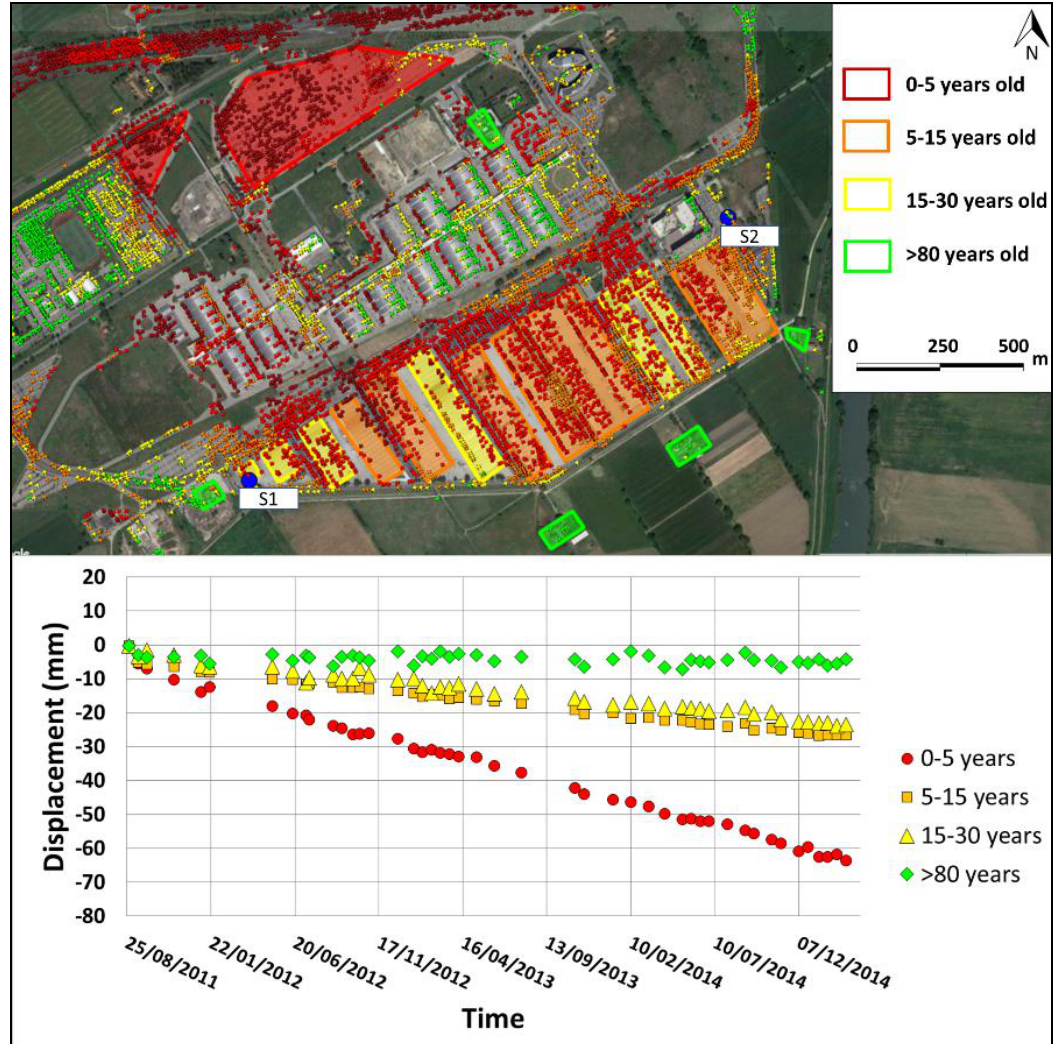
Figure 18. Age interval and time series of displacement of representative persistent scatterers belonging to structures used to check the comparability with the theoretical estimation of settlement. Blue dots represent the localisation of the boreholes used in this phase.